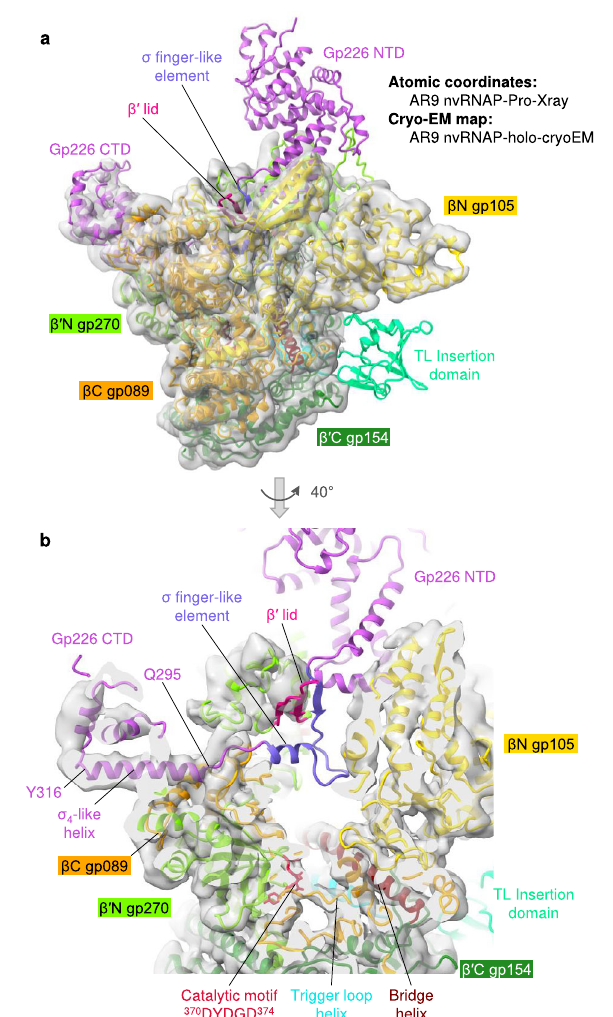
Fig. 6 Structure of the promoter speci fi city subunit gp226. a Ribbon diagram of gp226 with regions structurally similar to bacterial σ factors colored in yellow green (helices 2.1 through 2.4 and 4.1) and gold ( fi nger). The unique N- and C-terminal domains colored medium orchid. Residue numbers and identities are given at key locations. The DNA strands are colored as in Fig. 2a, b and are semitransparent. The pseudo − 35 -element binding motif is turquoise and its positively charged and solvent-exposed residues are shown in a stick representation. Inset: Conservation of residues comprising the 2.1bis helix. WebLogo 78 shows a 2.1bis helix- centered fragment of a full-length multiple sequence alignment, calculated using ClustalX 77 , of twelve gp226 homologs currently available at GenBank. b Ribbon diagram of the E. coli σ E factor (PDB code 6JBQ 22 ) with its helix- turn-helix motif colored in orange red. Positively charged residues that interact with the DNA are shown in a stick representation and labeled. The DNA backbone is semitransparent. structure and location within the RNAP holoenzyme complex suggest that all these proteins have a common ancestor.